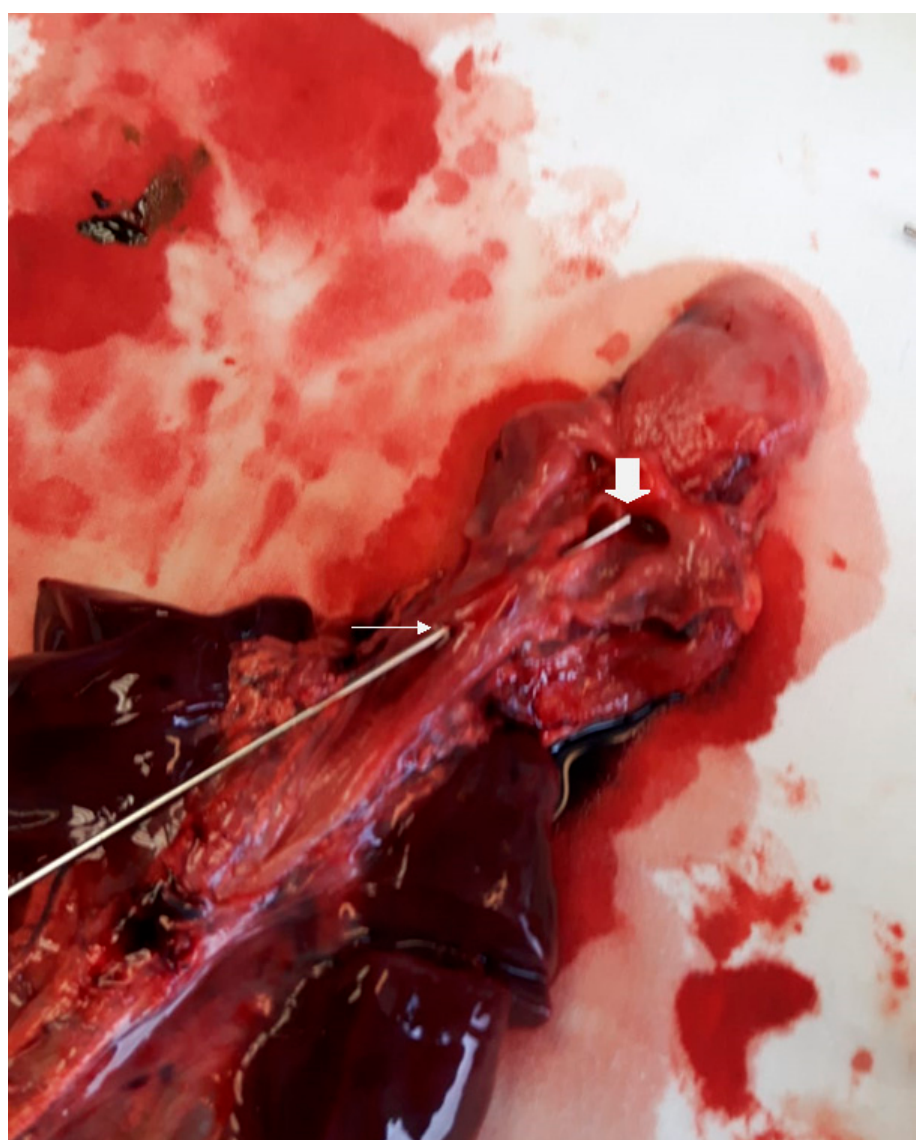
Figure 3. Postmortem specimen. The esophagus was opened posteriorly: a metallic probe is passed through the laryngeal lumen perforating the subglottic obstruction ( large white arrow ); the metallic probe passes through the TEF ( small white arrow ).